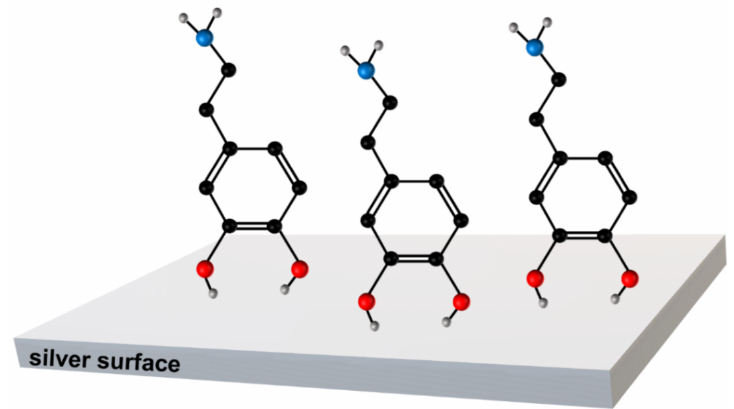
Figure 7. Schematic drawing showing the orientation of the dopamine molecules versus the silver surface when the dopamine is adsorbed from the solution containing an electrolyte.